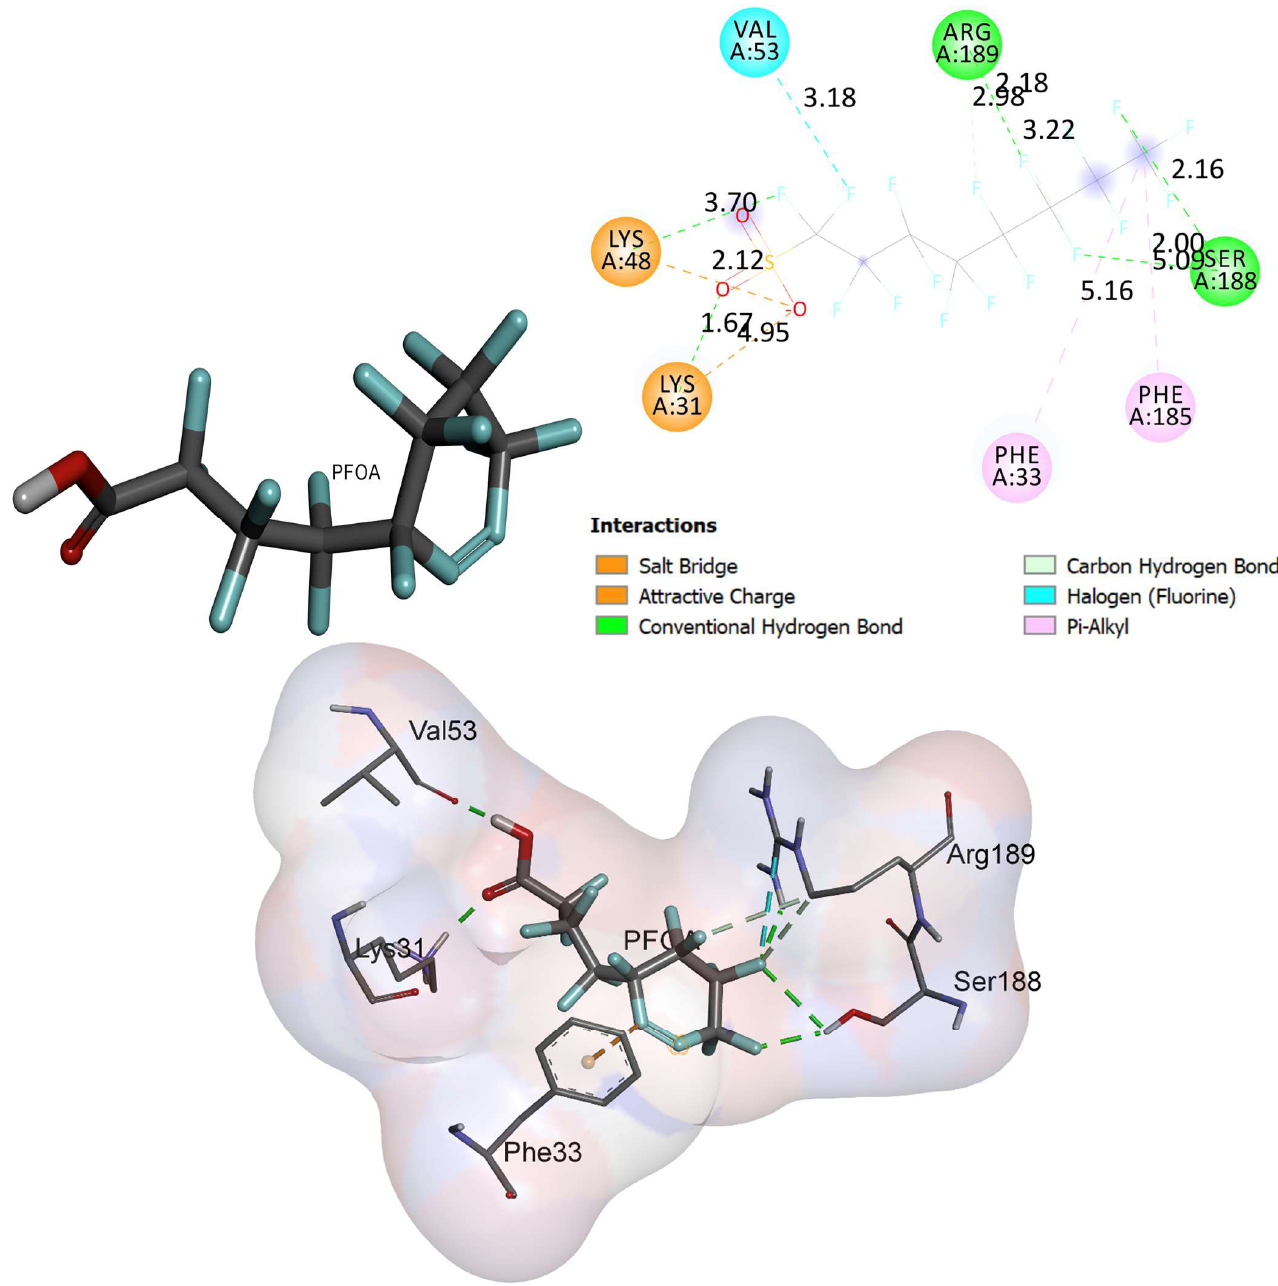
Figure 6. The interactions between carboxypeptidase t and n-sulfamoyl-l-lysin in vulgaris and ligands; ( a ) PFOS, and ( b ) PFOA.